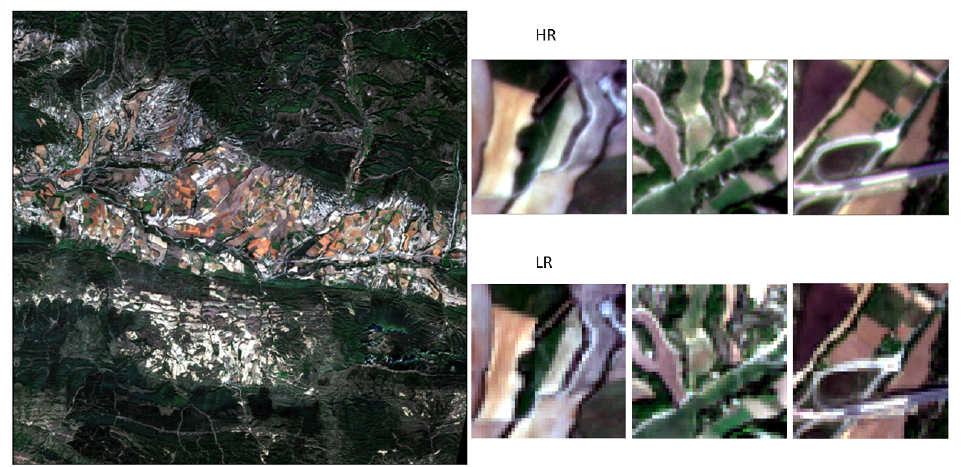
Figure 2. LR-HR pairs from the dataset. On the left an image from Navarre; on the right some tiles of the same image in high and low resolution. Table 2. Sentinel-2 and PlanetScope